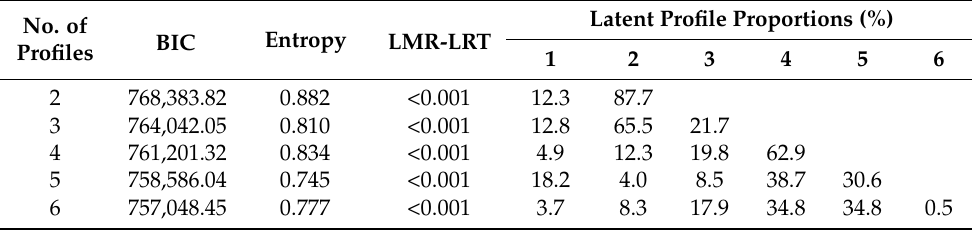
Table 1. Model fit statistics of latent profile models ( N = 15,723).